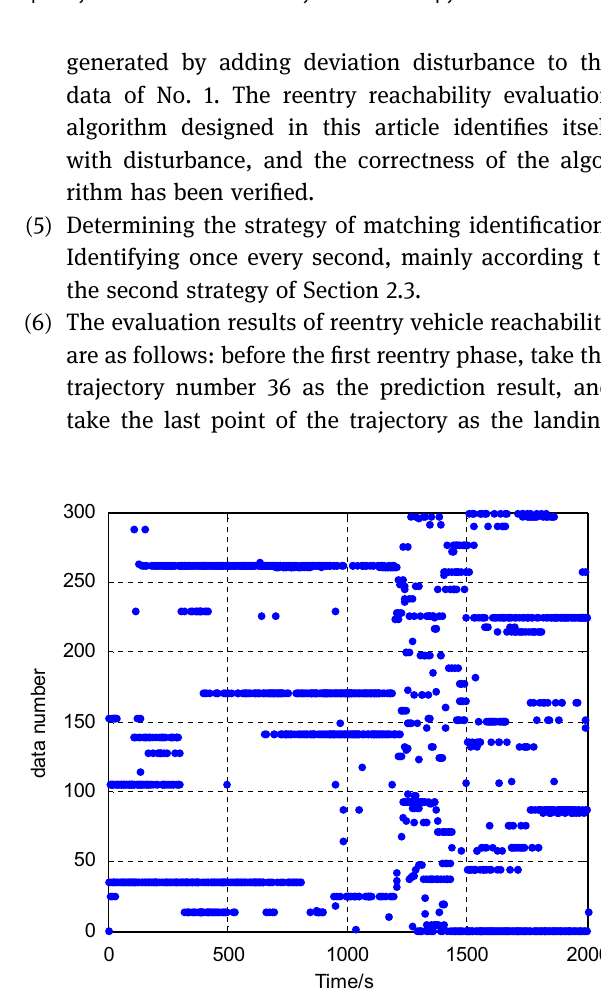
Figure 5: Identi fi cation results of matching sequence number fre - quency statistics based on fuzzy relative